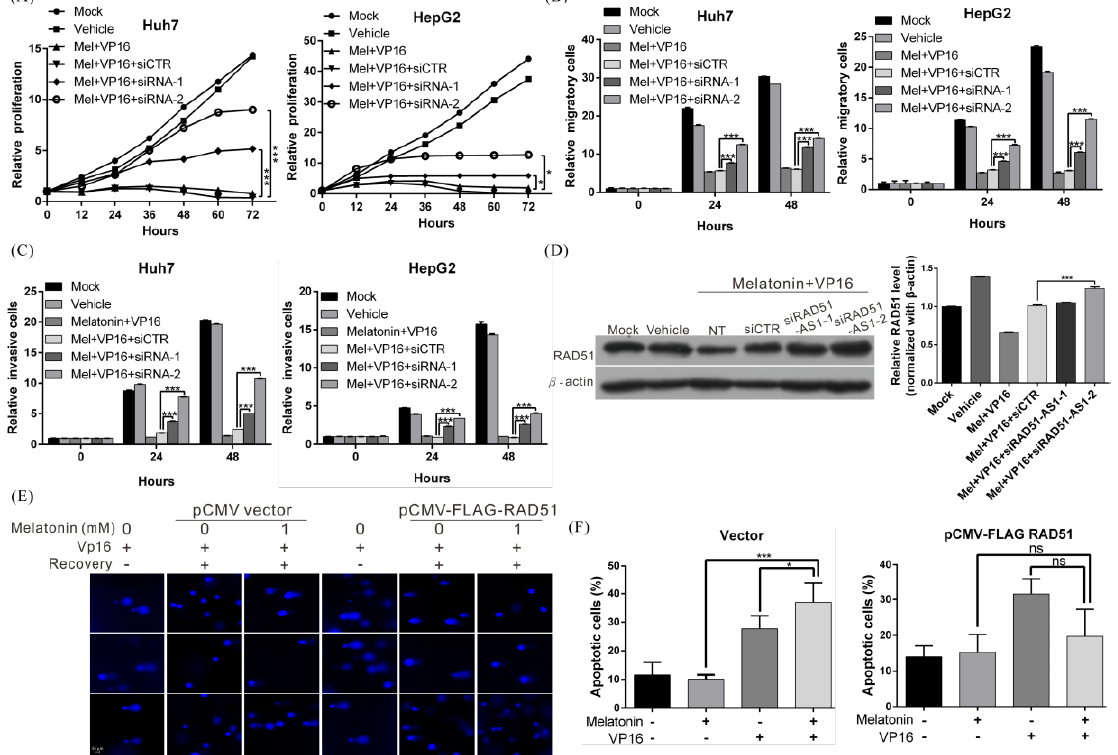
Figure 6. Melatonin enhanced the sensitivity of HCC cells to chemotherapy by inducing lncRNA RAD51-AS1 expression. ( A – C ) The effects of melatonin combined with etoposide (VP16) on Huh7 and HepG2 cell proliferation, migration and invasion with/without treatment with RAD51-AS1 siRNA (50 nM). p < 0.05 (*), p < 0.001 (***) ( D ) Western blot analysis shows the effect on expression of RAD51 in Huh7 cells after the aforementioned treatments (left panel). Quantitative results are shown in the right panel. p < 0.001 (***). ( E ) A comet assay showing that overexpression of RAD51 attenuated the melatonin-mediated inhibition of DNA repair. ( F ) An trypan blue exclusion assay showing that melatonin enhanced etoposide-induced apoptosis, whereas the apoptosis ratio was significantly decreased when RAD51 was overexpressed. All experiments were performed in triplicate.